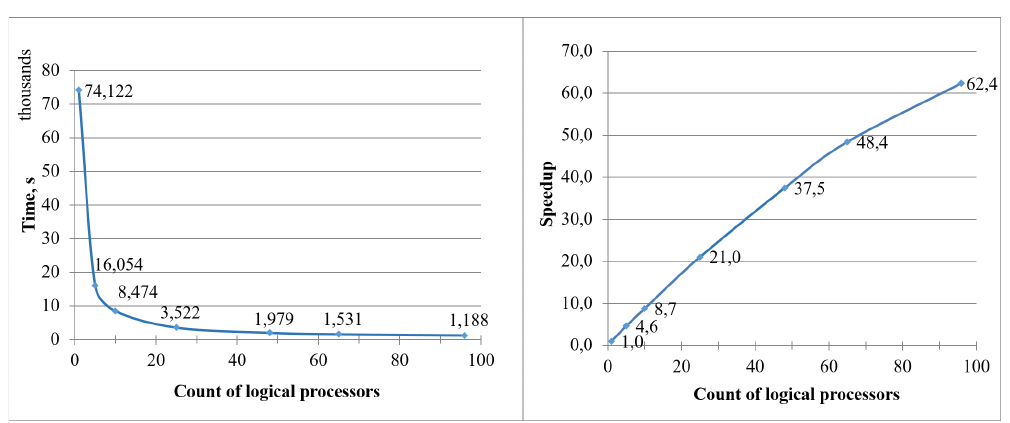
Figure 2. The dependence of the time (left graph) and the speedup (right graph) of the Mock Data Challenge on the number of processor